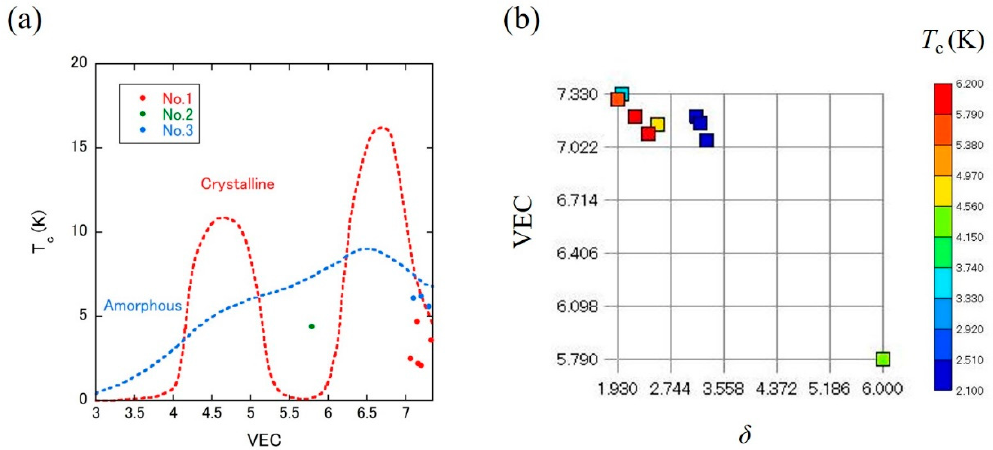
Figure 5. ( a ) VEC dependence of T c for hcp and hcp-related HEA superconductors. The same dependences are also shown for a crystalline 4 d metal solid solution and amorphous 4 d metal superconductors by the dotted lines. Data for the dotted lines are from [16]. ( b ) δ and VEC dependence of T c for hcp and hcp-related HEA superconductors.